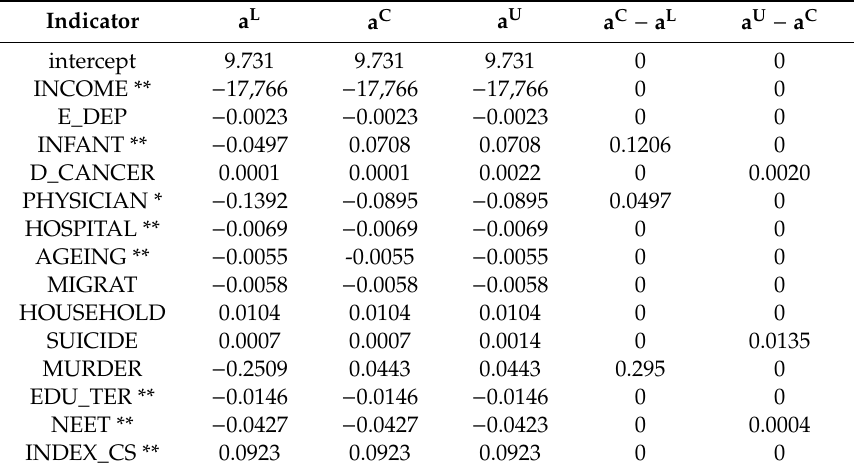
Table 3. Fuzzy coe ffi cients of the regression model. Acceptance of the predictor at the significance levels of 0.05 (**) and 0.1